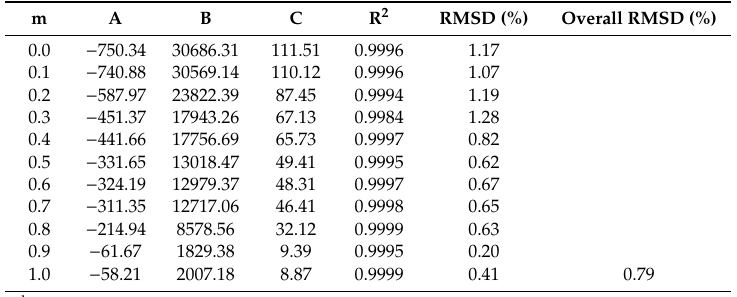
Table 5. Apelblat model parameters ( A, B , and C), R 2 and RMSD for PPD in binary DMSO + water mixtures d .